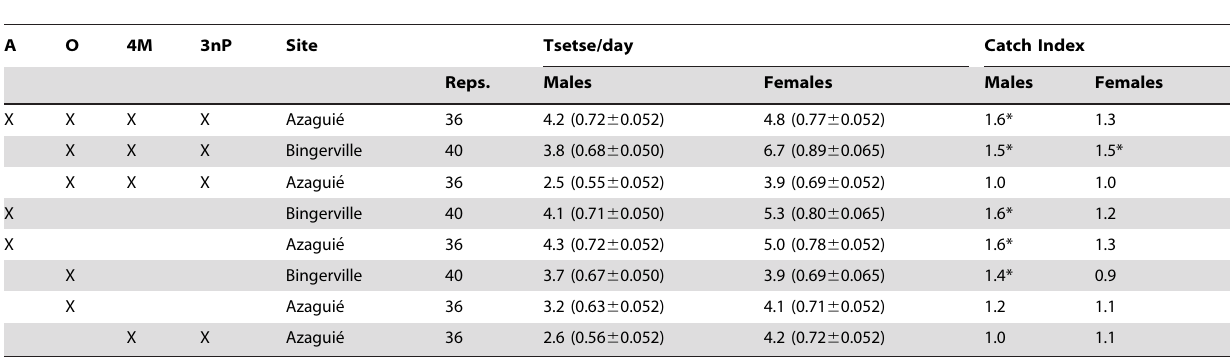
Table 7. Detransformed mean daily catch (transformed means 6 SED in brackets) of G. p. palpalis from traps baited with synthetic host